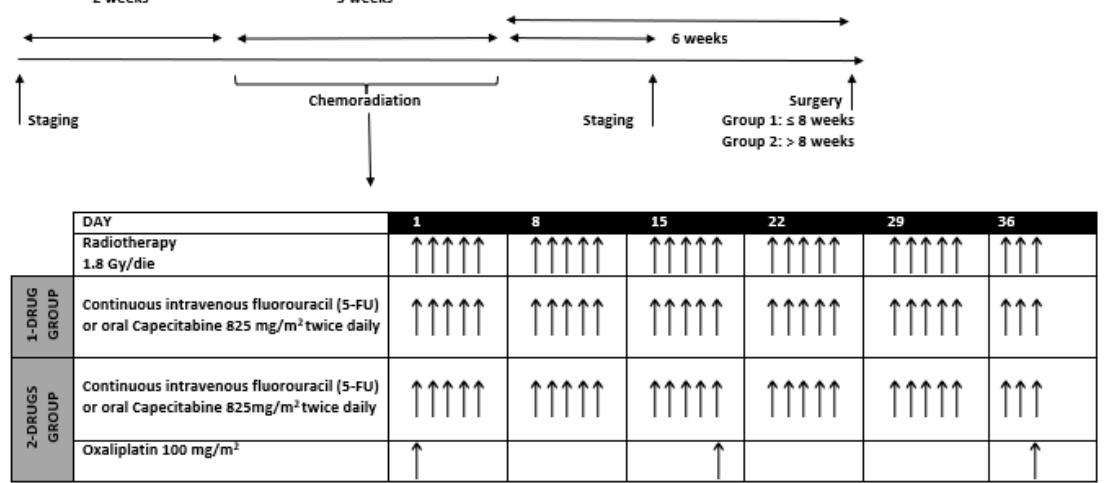
Figure 1. Time scheduling and concomitant chemoradiation regimen: continuous intravenous fluorouracil or oral capecitabine was given each day of radiation, for five days a week; oxaliplatin was given every 19 days.